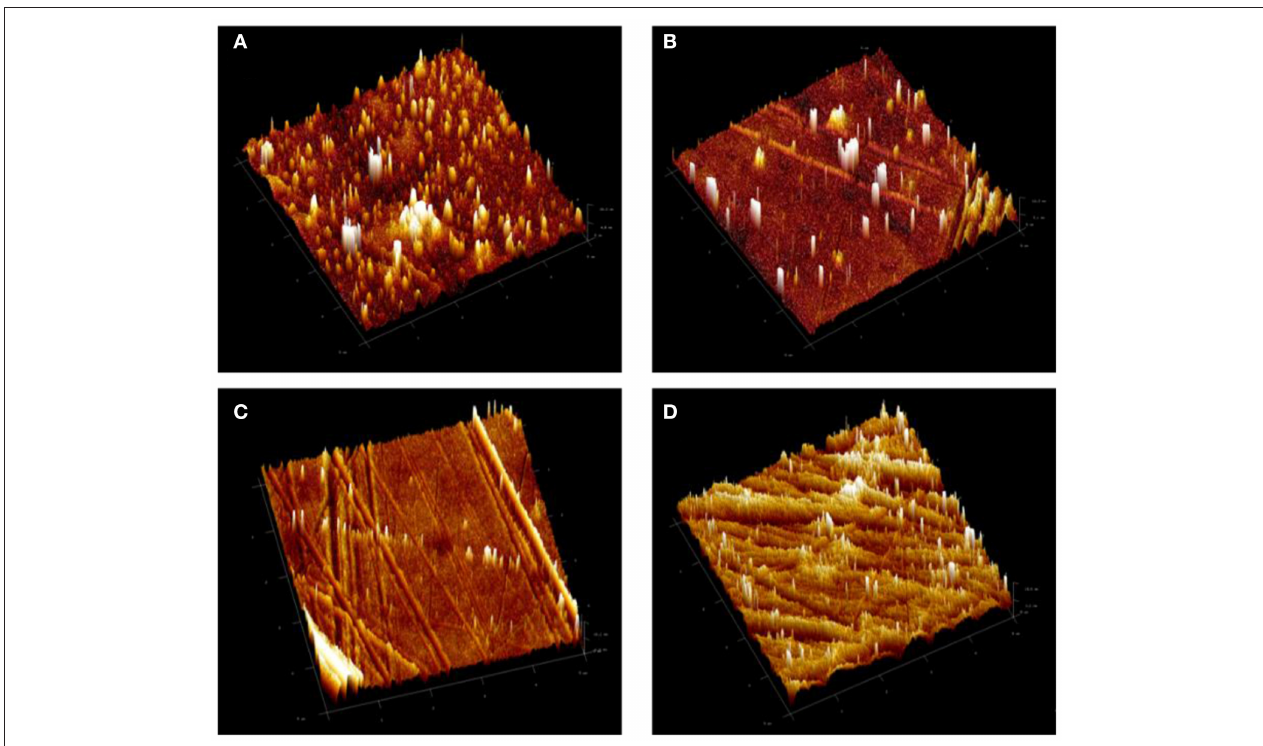
FIGURE 5 | 3D atomic force microscopy (AFM) images of (A) PDMS modified epoxy, EP, coating system and (B) EPT1, (C) EPT2, and (D) EPT3 PDMS modified epoxy-TiO